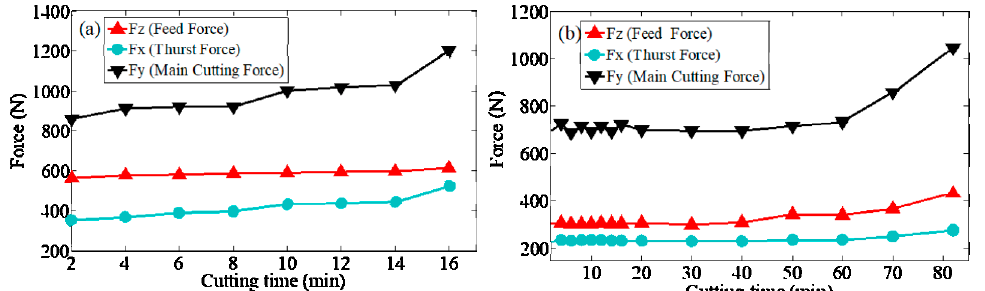
Figure 8. ( a ) Tool A three-direction cutting force. ( b ) Tool B three-direction cutting force.